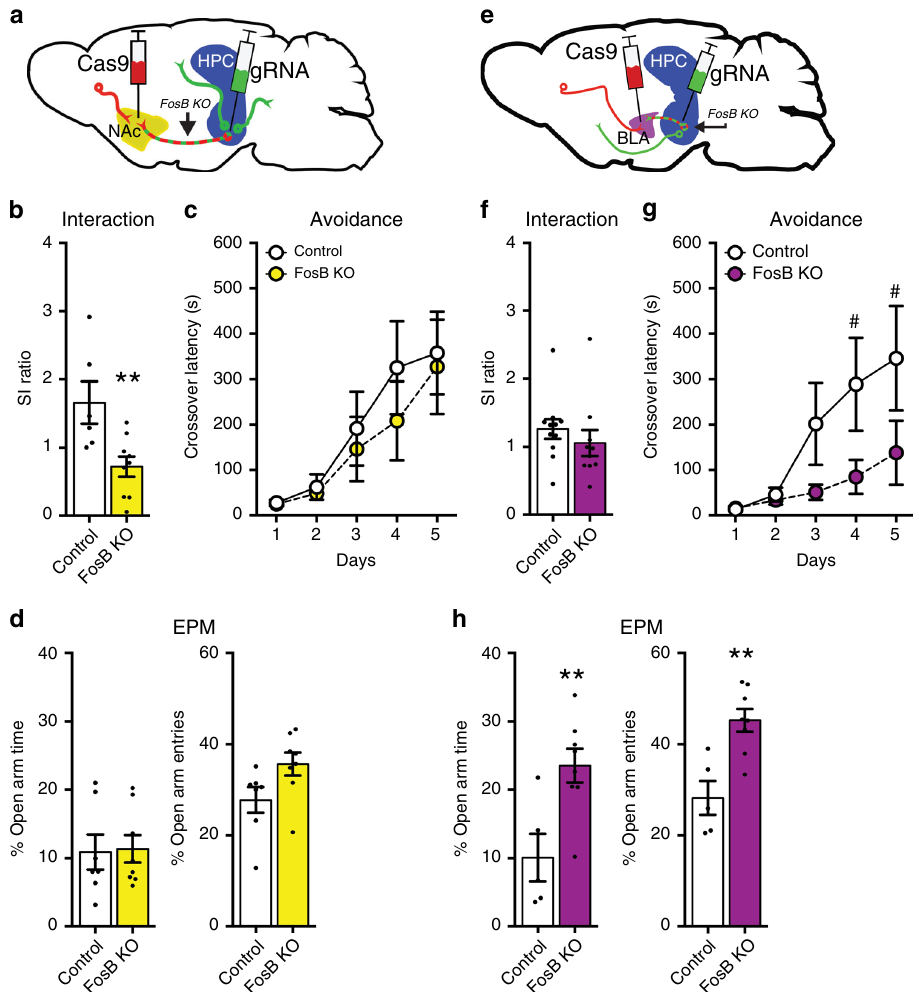
Fig. 2 Circuit-speci fi c silencing of FosB gene in ventral hippocampal projection neurons. a Schematic of dual-vector CRISPR tool to silence FosB in vHPC- NAc afferent neurons. Retrograde vector expressing Cre-dependent Cas9 (Cas9; red) is injected into NAc while local vector expressing Cre and FosB guide RNA (gRNA; green) is injected into vHPC. FosB silencing ( FosB KO) occurs only in co-transduced vHPC-NAc neurons. b FosB silencing in vHPC-NAc neurons heightens stress-induced social avoidance. ** P = 0.0092 ( n = 6 control, n = 9 FosB KO; independent samples t -test compared to control). c FosB silencing in vHPC-NAc does not affect crossover latency in the passive avoidance learning paradigm ( n = 7 control, n = 8 FosB KO), or d anxiety-like behavior in the elevated plus maze (EPM). e Schematic of dual-vector CRISPR silencing FosB in vHPC-BLA neurons. f FosB silencing in vHPC-BLA does not affect stress-induced social avoidance ( n = 11 control, n = 10 FosB KO). g FosB silencing in vHPC-BLA impairs avoidance learning. # P = 0.0614 ( n = 6 control, n = 8 FosB KO; two-way mixed ANOVA with Holm – Sidak post-tests compared to control). h FosB silencing in vHPC-BLA decreases anxiety-like behavior in the EPM, increasing time spent and entries into the open arms. ** P = 0.0079 for time spent and ** P = 0.0022 for entries ( n = 5 control, n = 8 FosB KO; independent samples t -test compared to control). All graphs are represented as mean ±